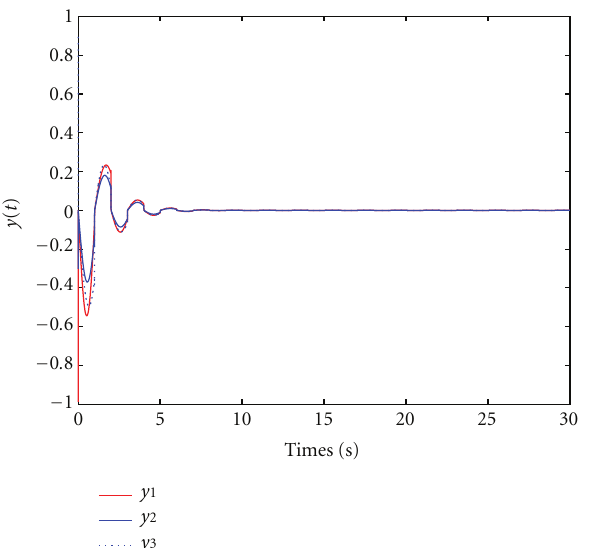
Figure 5: State responses of the open-loop system. Figure 6: State responses of the closed-loop